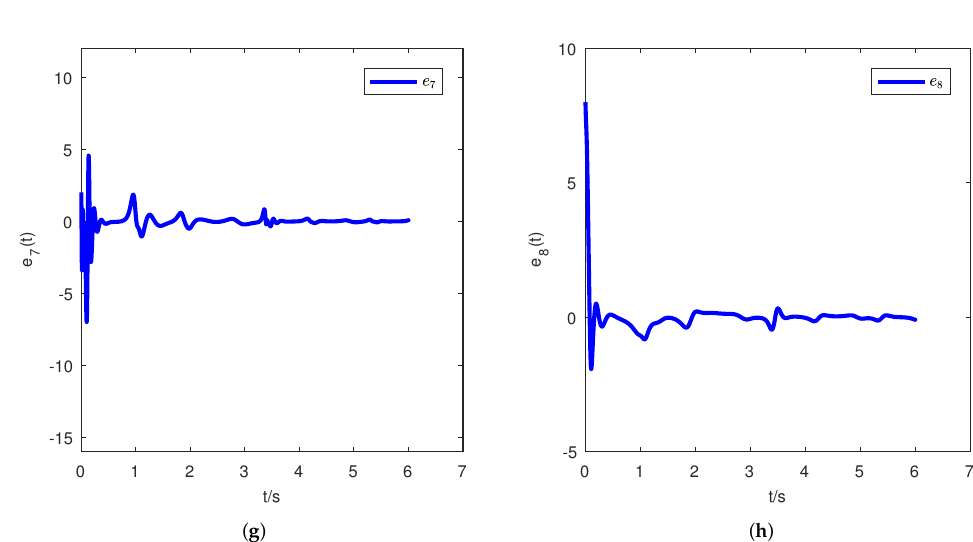
Figure 3. ( a – h ): Error signals between drive system (35) and response system (37).